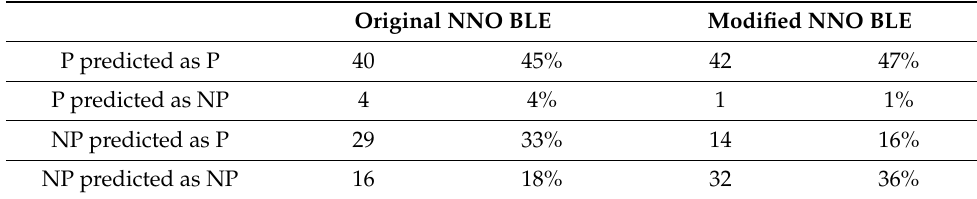
Table 5. Overview of Original and Modified NNO BLE